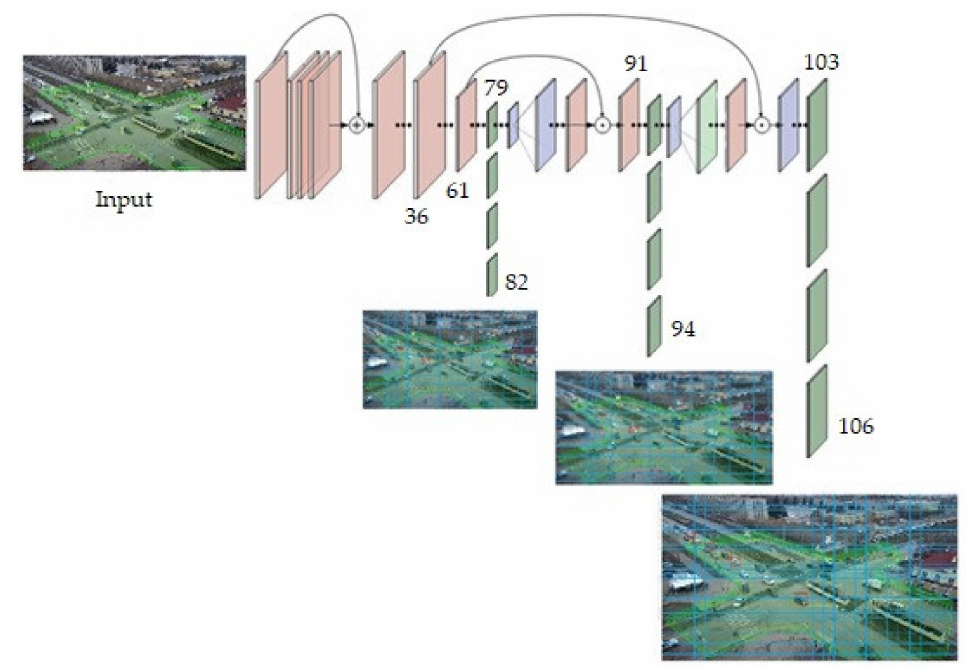
Figure 1. YOLOv3 neural network architecture.